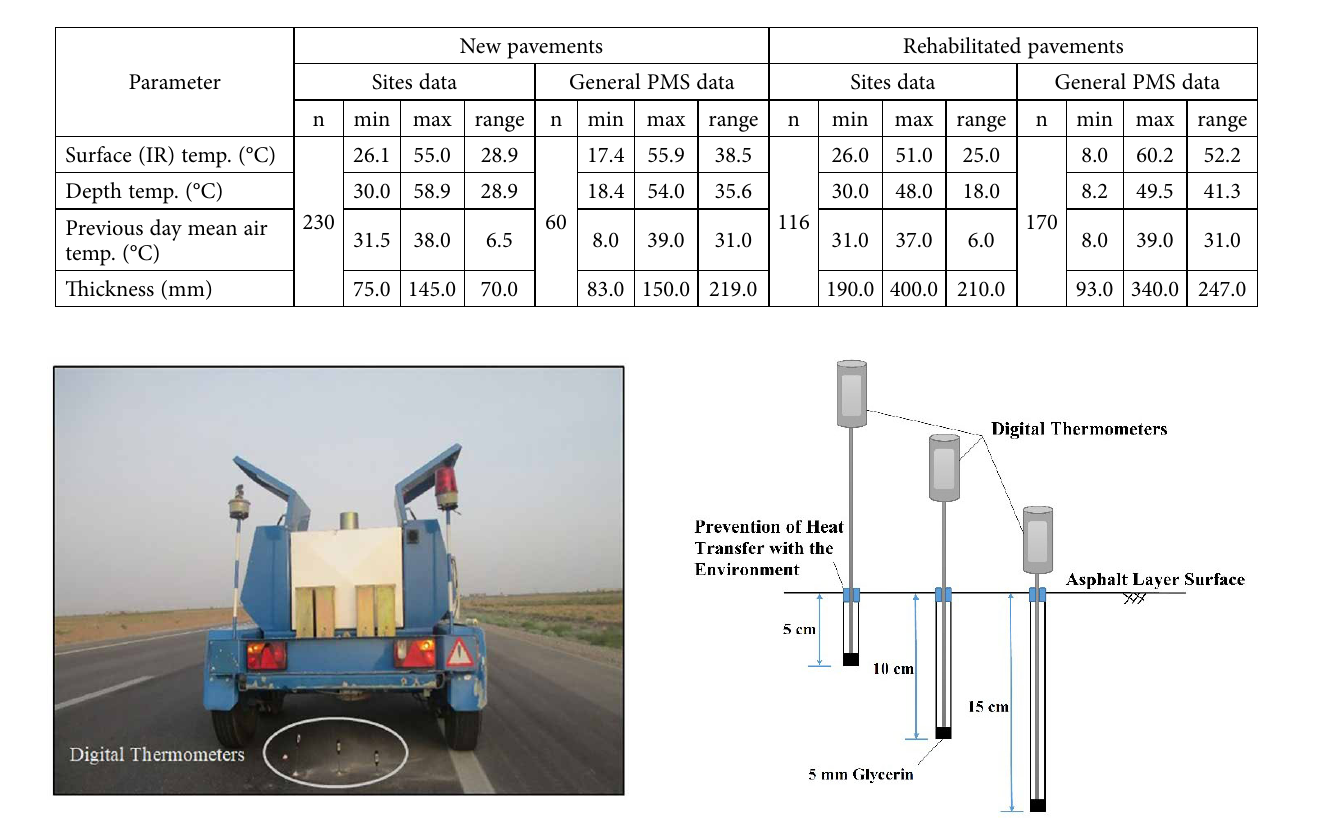
Figure 3. FWD testing and depth temperature measurements of asphalt layers on a pavement